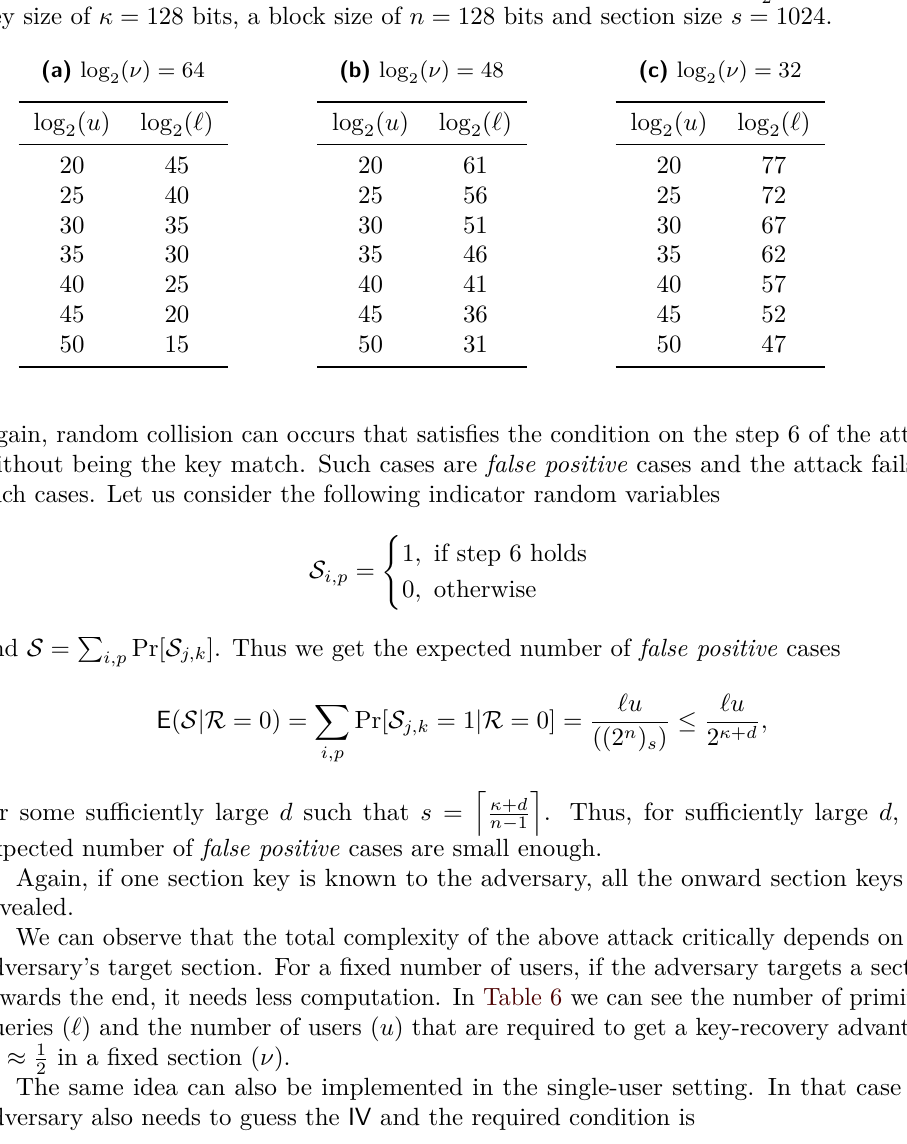
. We consider a 2